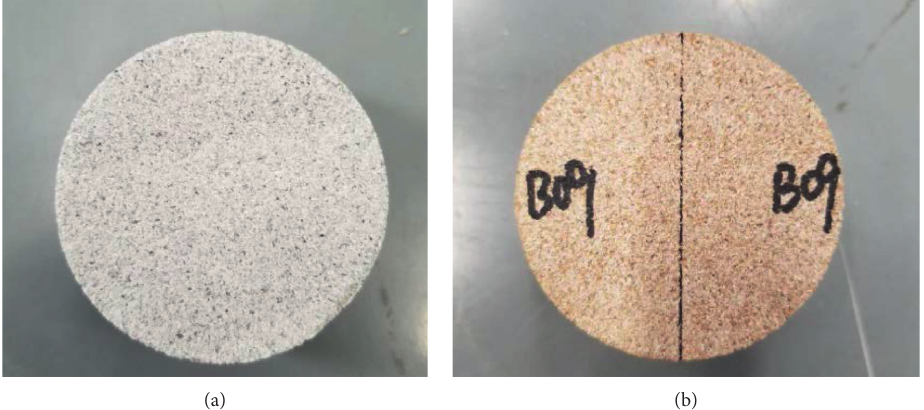
Figure 5: The color change of Sichuan sandstone (a) at room temperature and (b) after treatment at 600 ° C.